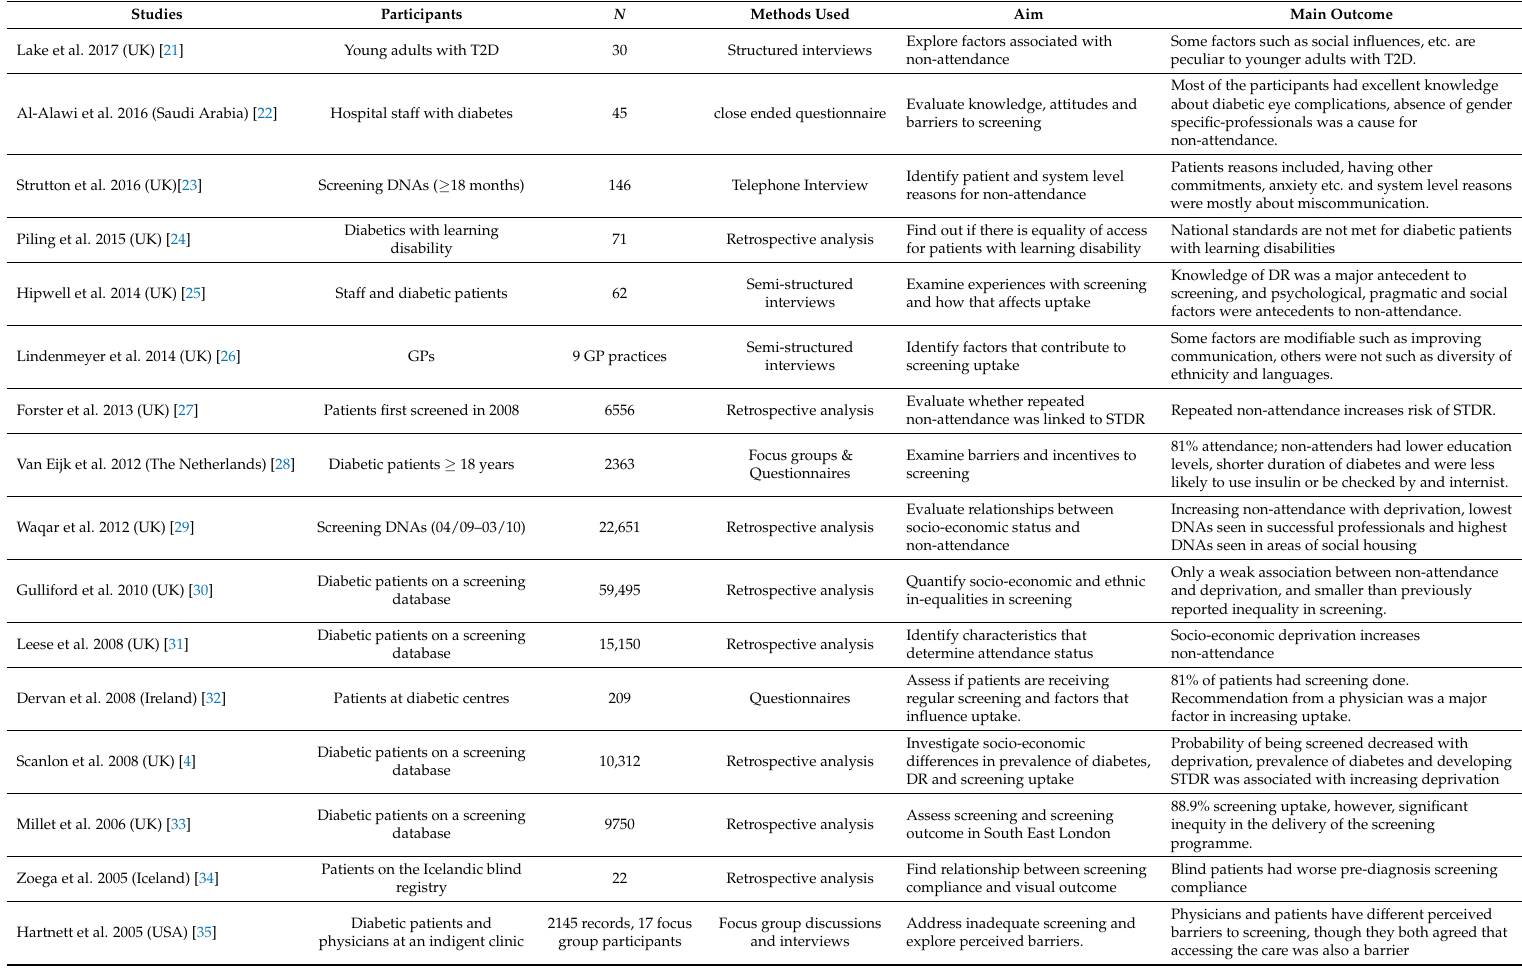
Table 1. Showing characteristics of included